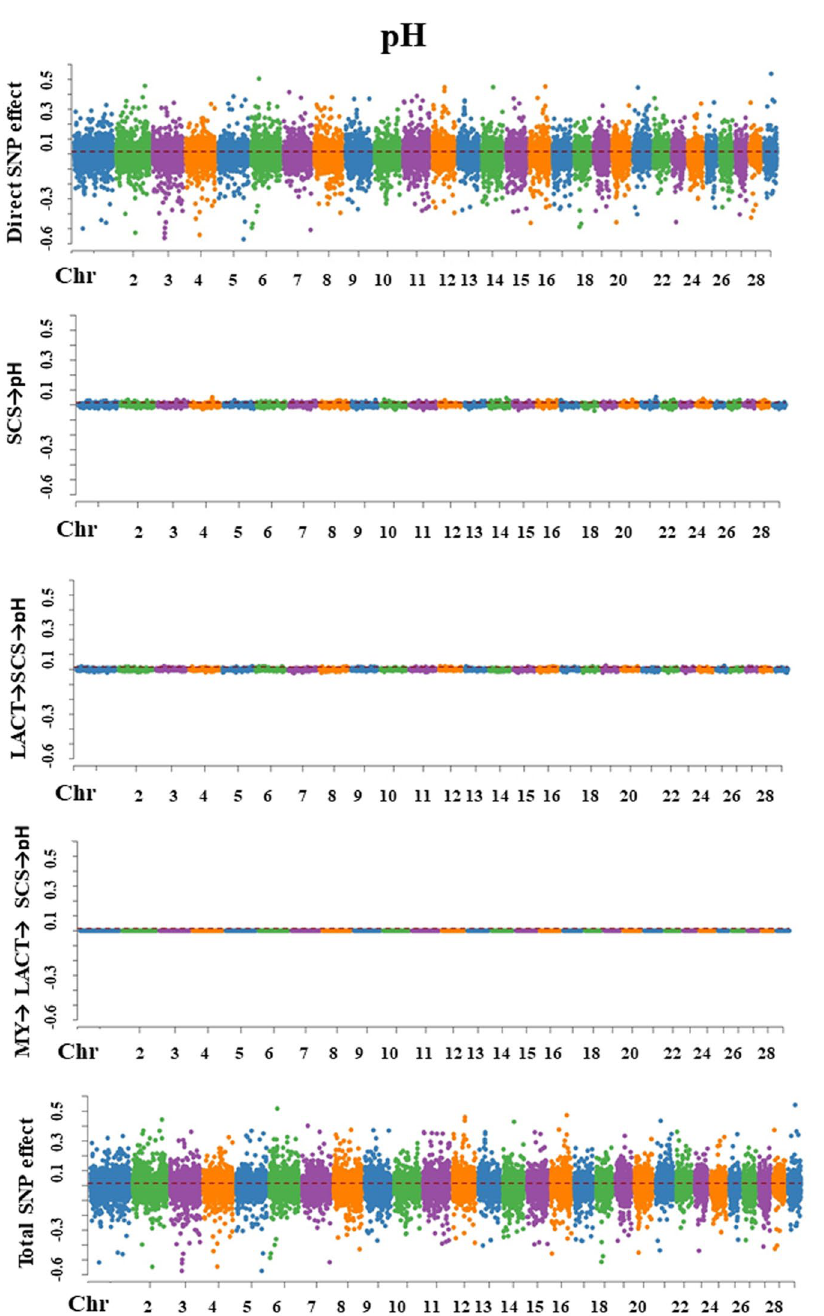
Figure 6. Manhattan plots for SNP effects on milk pH obtained using SEM-GWAS based on the network structure learned by Hill-Climbing algorithm. MY: milk yield; LACT: lactose; SCS: somatic cell